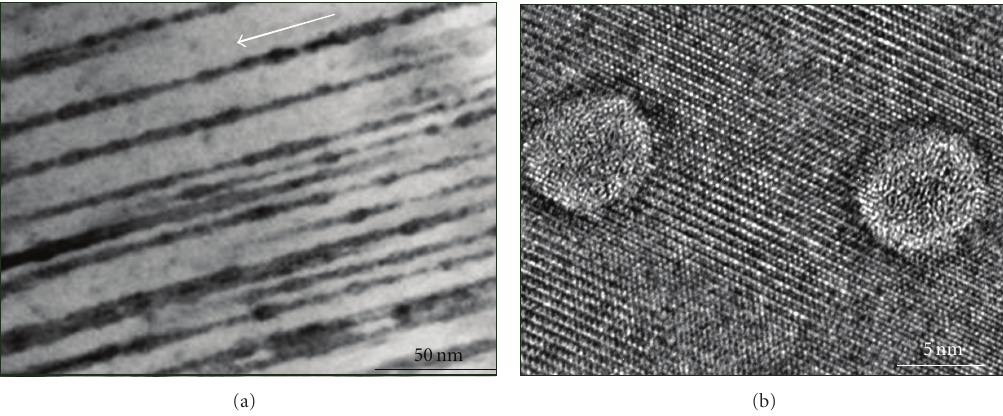
Figure 9: TEM micrographs recorded on a Gd 2 Ti 2 O 7 crystal irradiated at RT with 870 MeV Xe ions at 2 × 10 11 cm − 2 . (a) Cross-section; (b) plane view with a higher